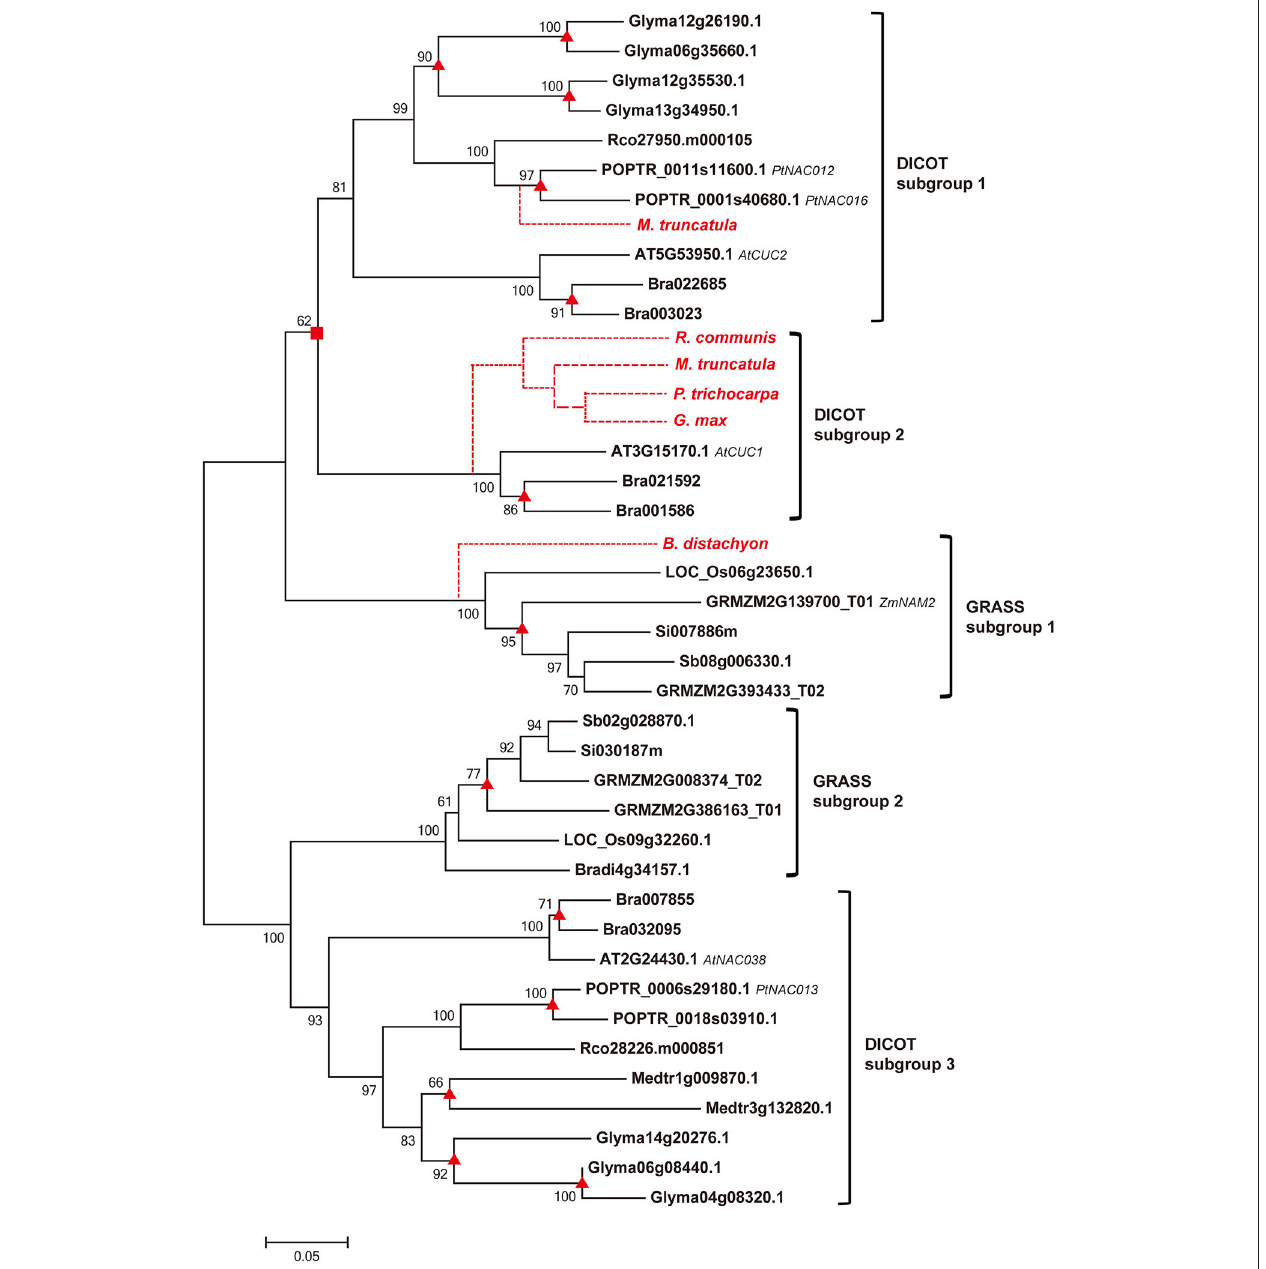
FIGURE 2 | Phylogenetic relationship of sequences within the COG Ia_1 by NJ method with bootstrap support above 50% shown at the nodes. Square boxes indicate ancient duplication events; the triangles indicate recently occurred species-specific duplication events; and the broken lines indicate absent genes, either lost from those species or not yet sequenced. Gene names, based on previous references, are listed after the gene